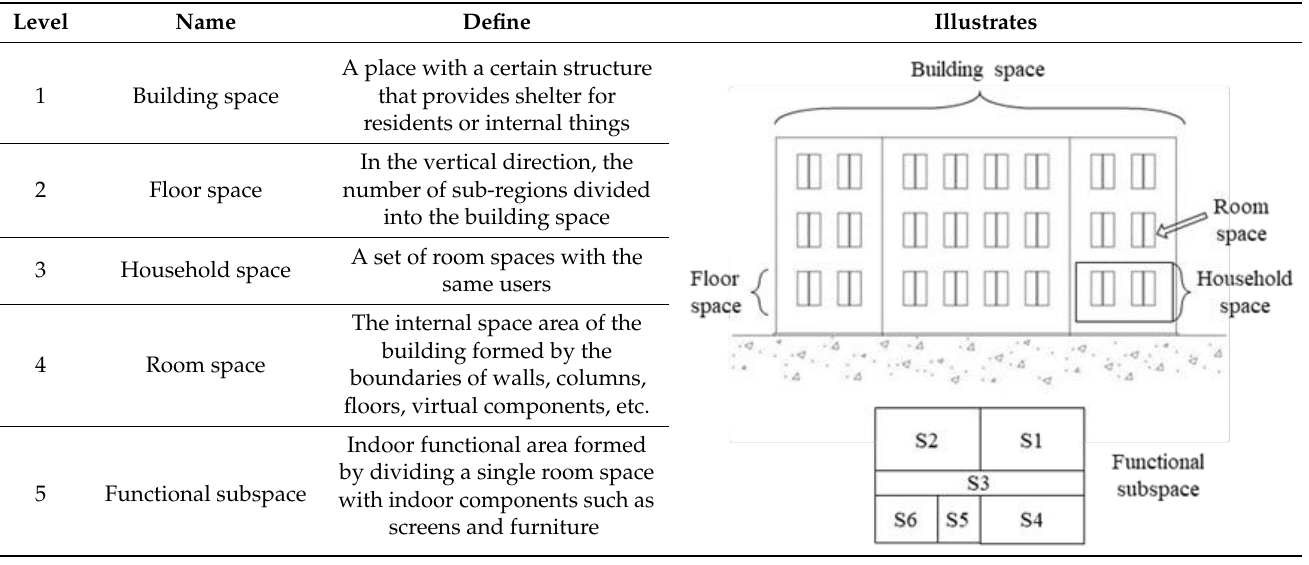
Table 1. Hierarchical level of indoor